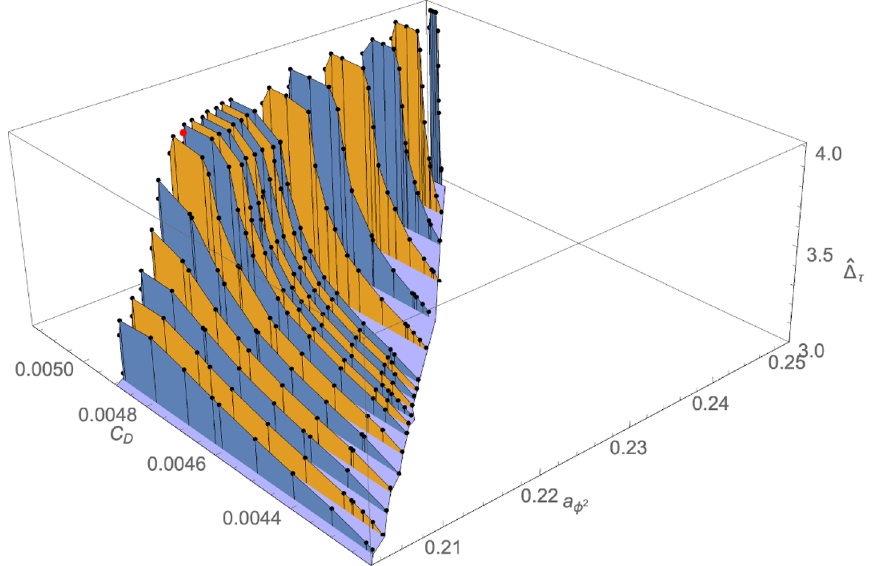
for several points in the most interesting region of figure 4. b τ for visibility. The red point has its φ 2